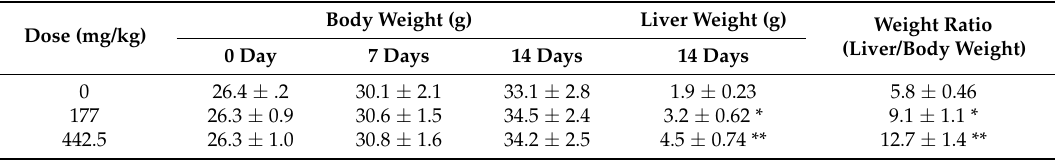
Figure 1. Experimental scheme for proteomic profiling of rifampicin-induced liver injury in mice. Four male ICR mice in each group were orally administered with 177 and 442.5 mg/kg rifampicin in 5% ( v / v ) dimethyl sulfoxide and 25% ( v / v ) polyethylene glycol (PEG) in water for 14 consecutive days. All animals were subjected to necropsy in 24 h after treatment. RIF: rifampicin; Rep.: replicate; TMT: tandem mass tag; LC-HR/MS: liquid chromatography-high resolution mass spectrometry; ALT: alanine aminotransferase; AST: aspartate transaminase; LDH: lactate dehydrogenase; ALP: alkaline phosphatase; CPK: creatine phosphokinase. Table 1. Effect of rifampicin on body and liver weights in male ICR mice.